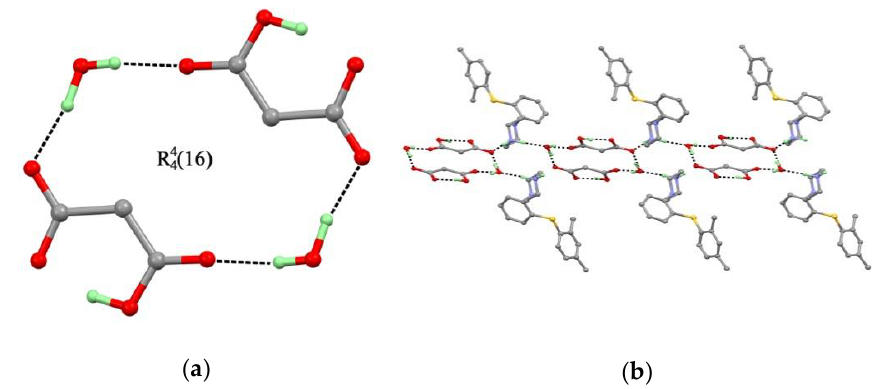
Figure 3. ( a ) Two MA anions and two water molecules form a tetrameric R 4 O5-H5A···O1 and O5-H5B···O2 hydrogen bonds; ( b ) The two-dimensional structure is connected by N1 + -H1A···O5 and N1 + -H1B···O2 hydrogen bonds.